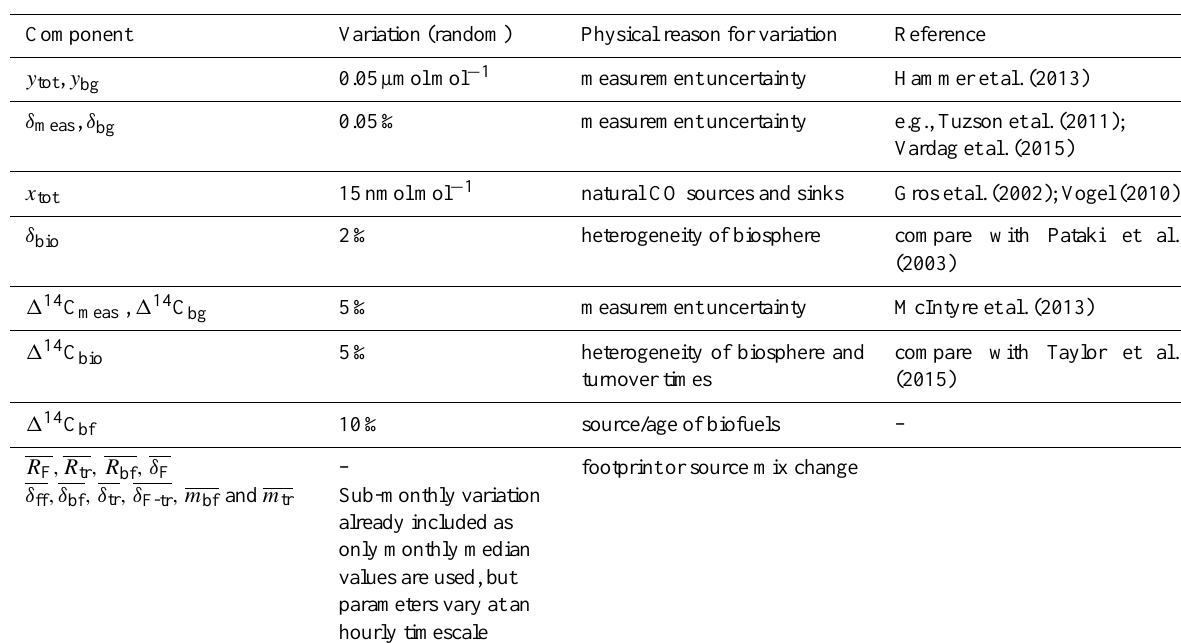
Table 3. Magnitude, physical reason and reference of parameter variation (included in Figs. 5–7). Component